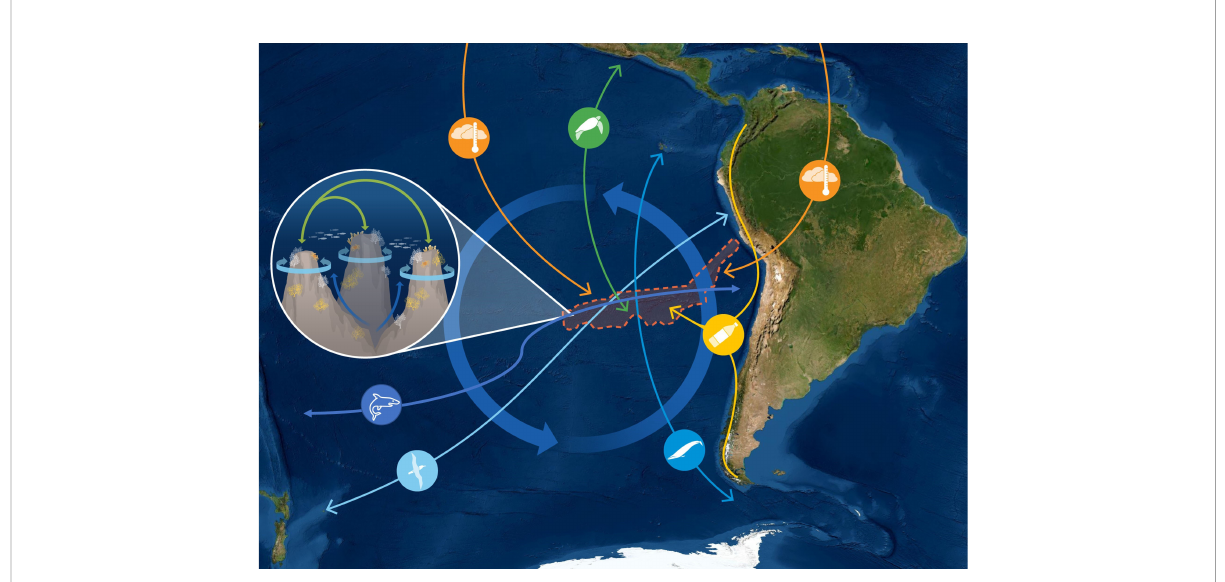
FIGURE 2 Diagram showing how the natural and cultural signi fi cance of the Salas y Go ́ mez and Nazca ridges are in fl uenced by connectivity via movement of organisms, nutrients, and